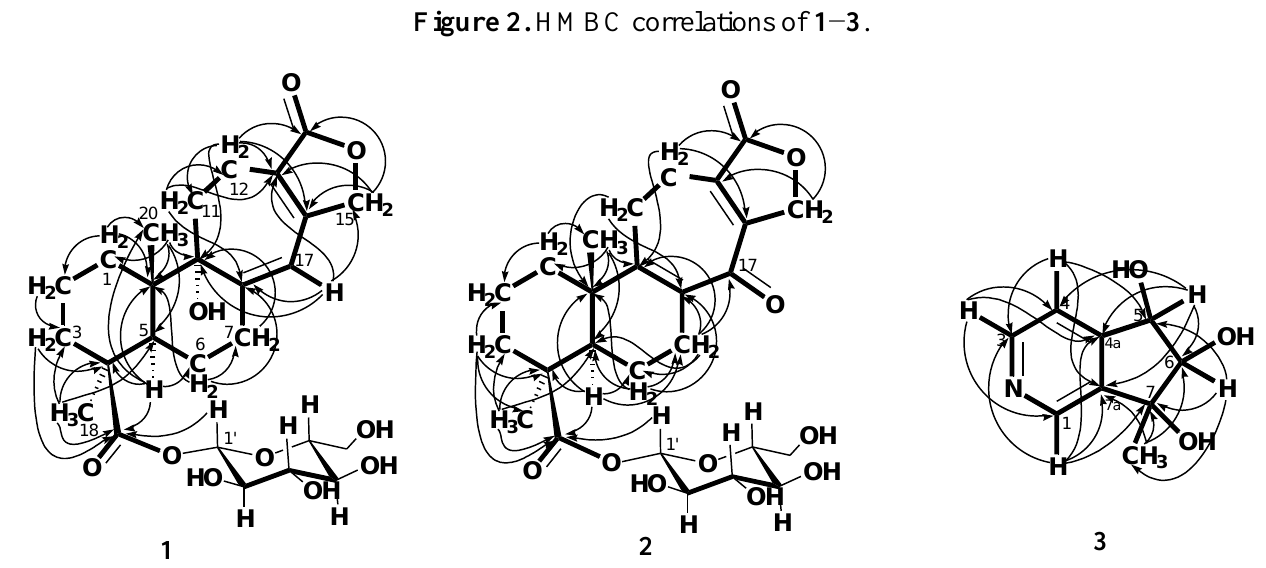
Figure 2. HMBC correlations of 1 − 3